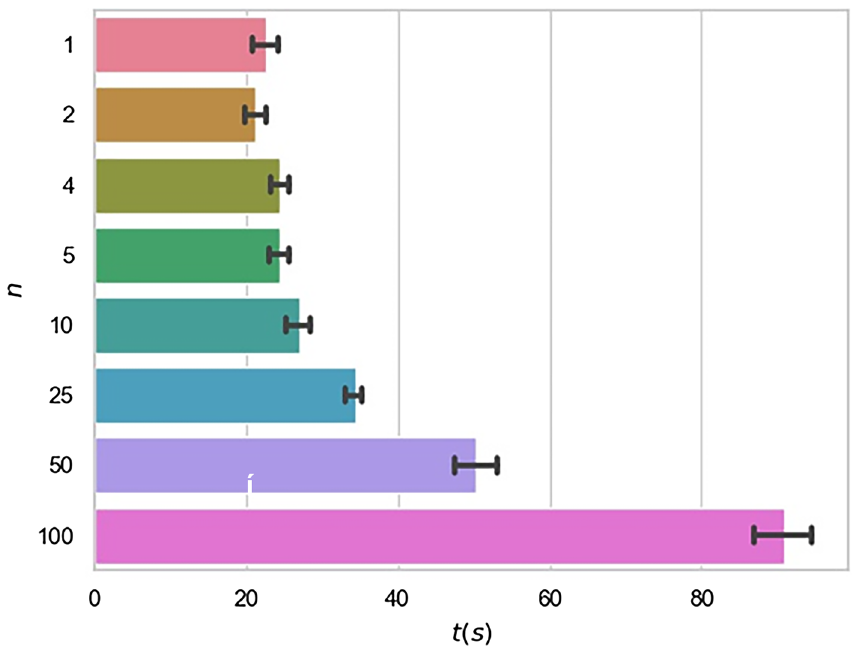
Figure 6. Bar chart of training time consuming with different communication times for model trained based on four clients. t is the time spent on model training, n is the communication